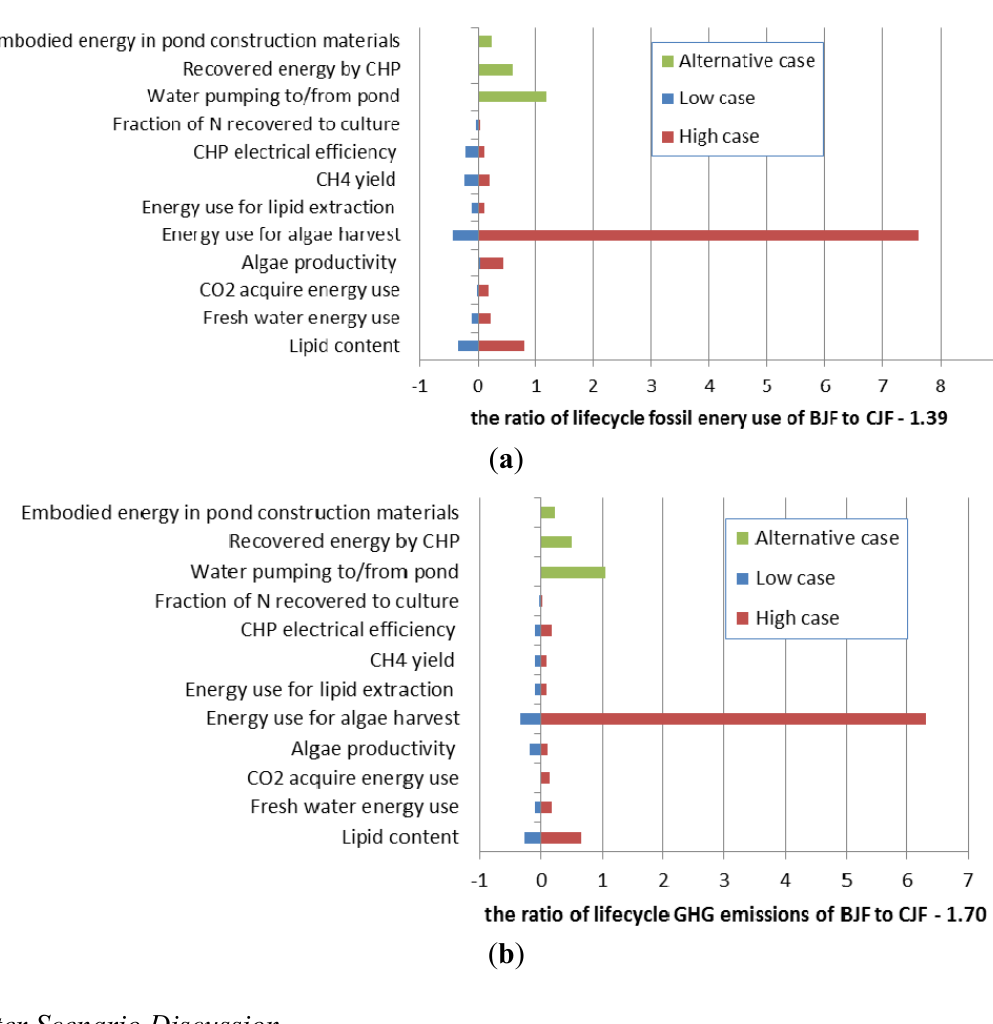
Figure 9. Sensitivity Analysis for algae baseline case: ( a ) Life cycle fossil energy use and ( b ) Lifecycle GHG